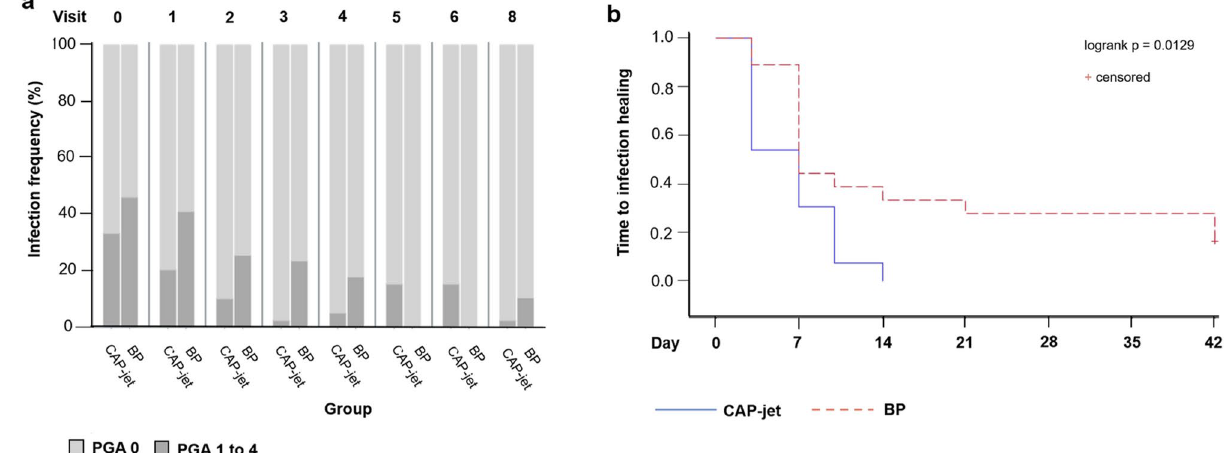
Figure 4. ( a ) Frequency of infection; ( b ) time to infection healing. ( a ) The newly emerged infection in CAP-jet group at v 8 was not imputed; in the BP group, one value at v 3 of one patient is missing, furthermore, the values of the patient who was transferred to another hospital after v 6 are missing in v 7 and v 8. Healed patients are considered as no